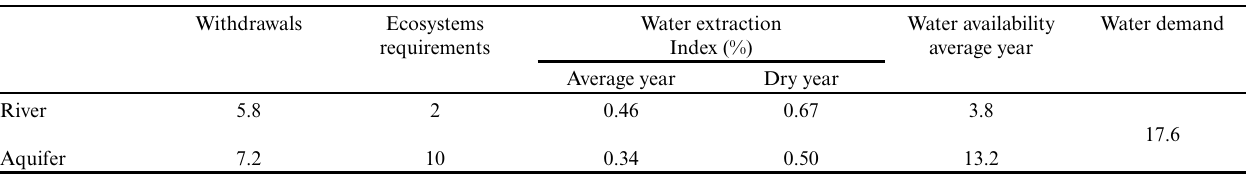
Table 7 . Water demand vs availability